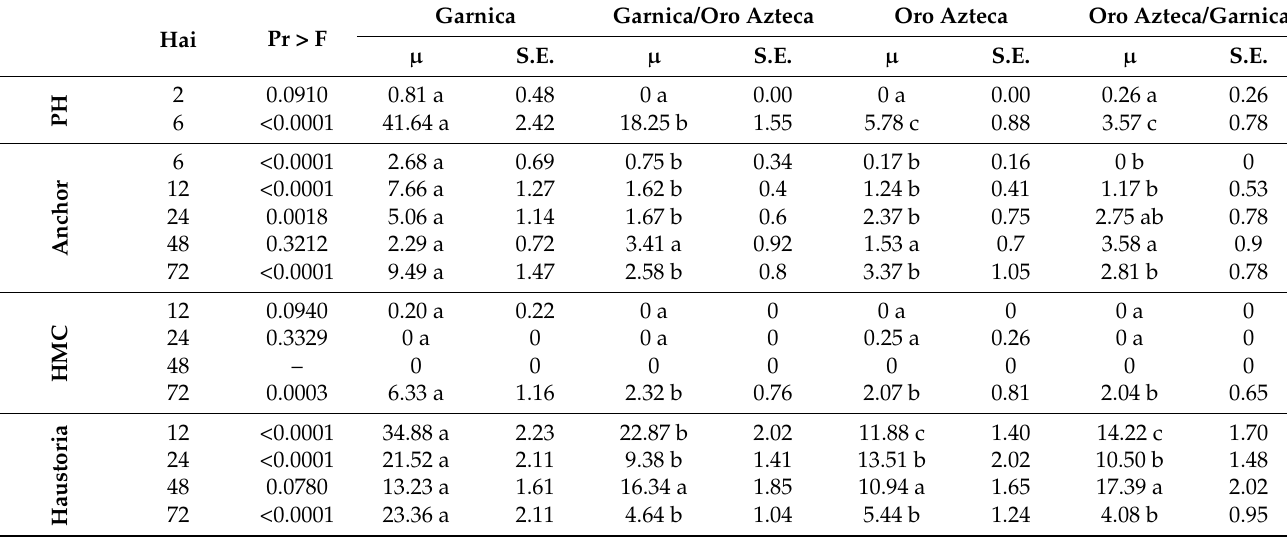
Table 2. Statistical values of fungal structure proliferation in inoculated leaves of ungrafted and grafted